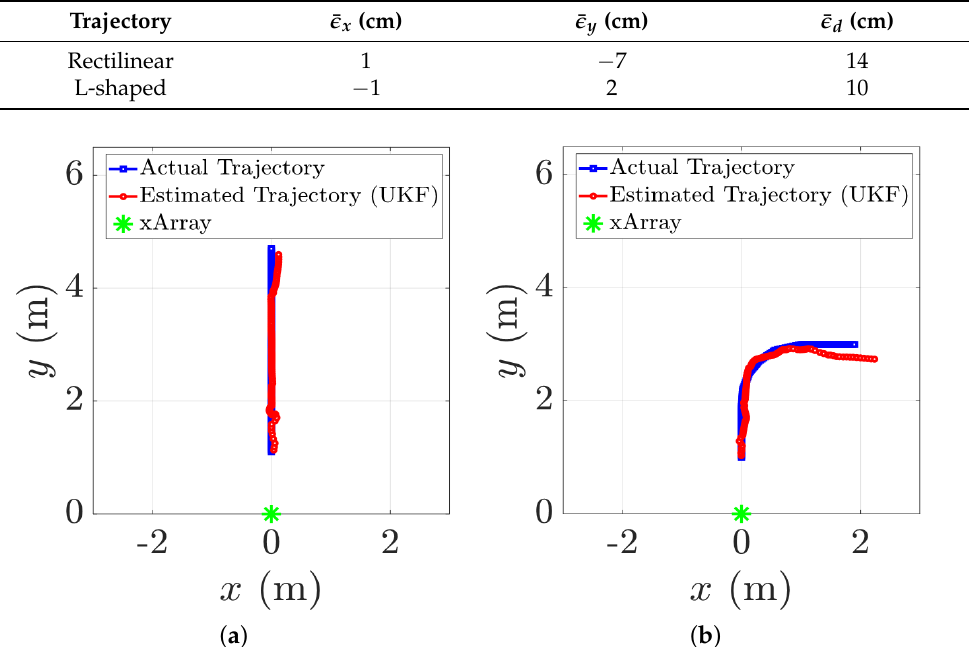
Table 3. Global Performance of the UHF-RFID tracking system in terms of mean localization error on the x -coordinate (¯ (cid:101) x ), y -coordinate (¯ (cid:101) y ) and 2D distance error (¯ (cid:101) d ). Trajectory